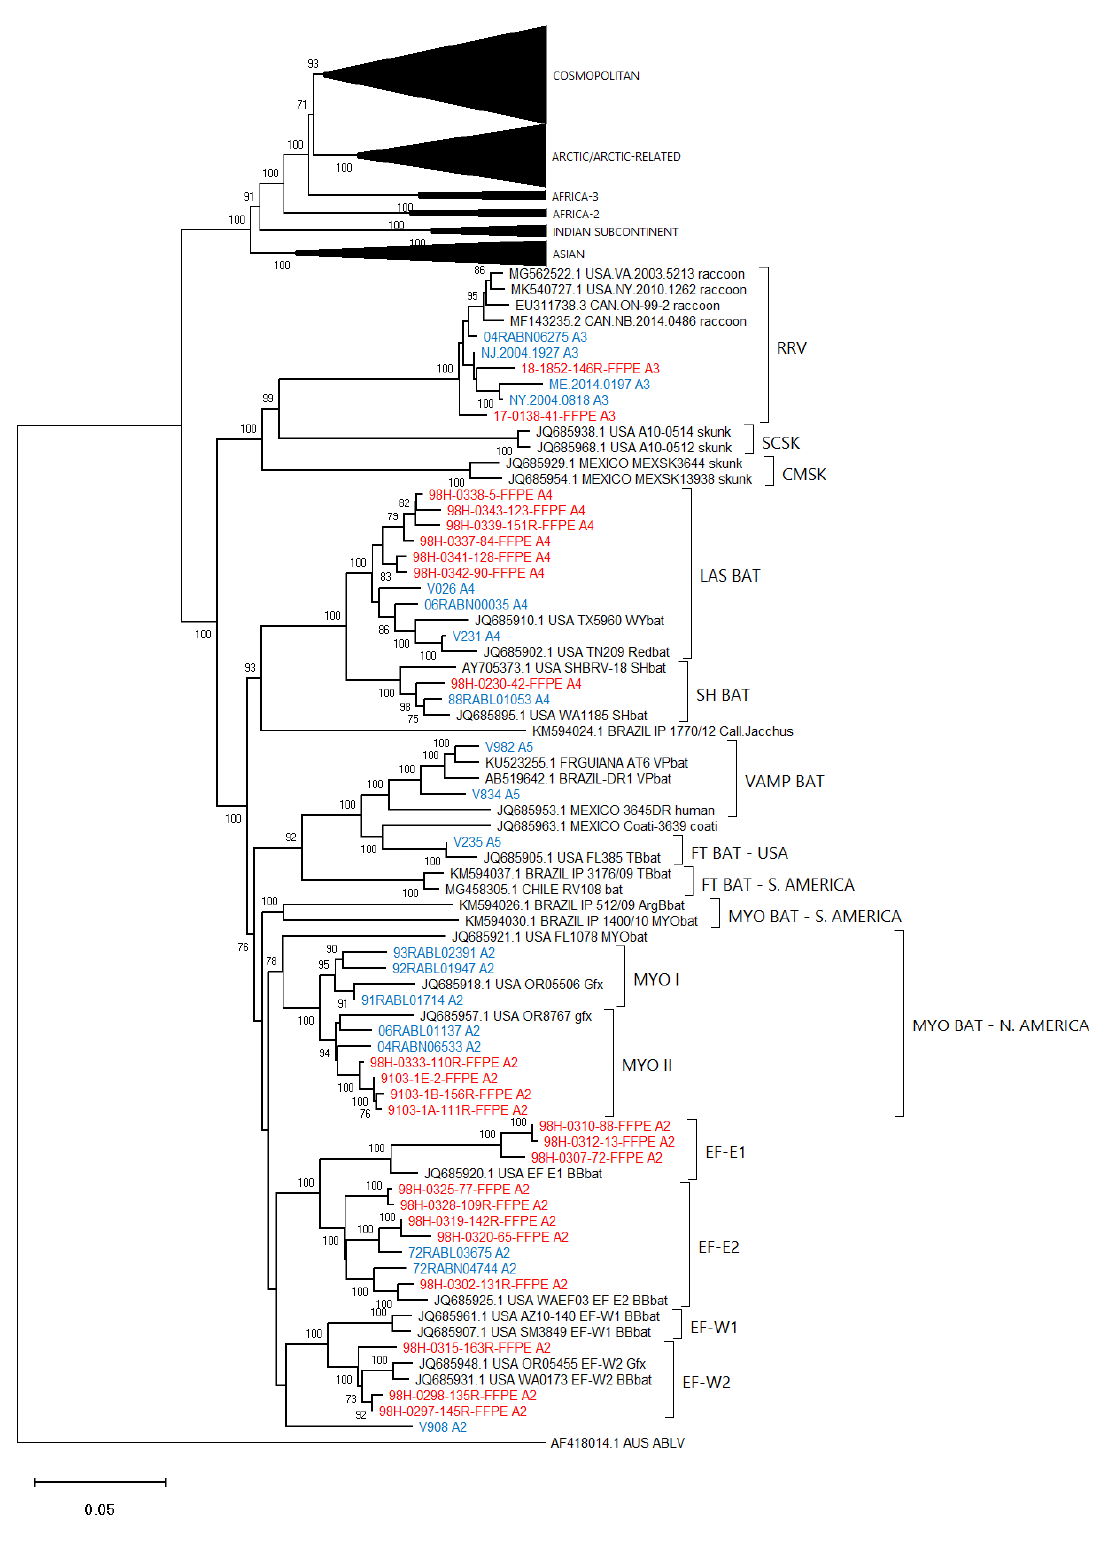
Figure 8. Neighbor joining tree of 86 RABV test samples and 100 representative RABV genomes showing details of the American Indigenous lineage. Sample genomes were reconstructed through reference-guided assembly of the Ampliseq reads using eight different references as indicated by the A1 to A8 suffix following the taxon name. Sequences generated from unfixed samples are shown in blue while those from FFPE samples are in red. Numbers at nodes indicate bootstrap values ≥ 70%. Lineages and variants are identified to the right of the tree.